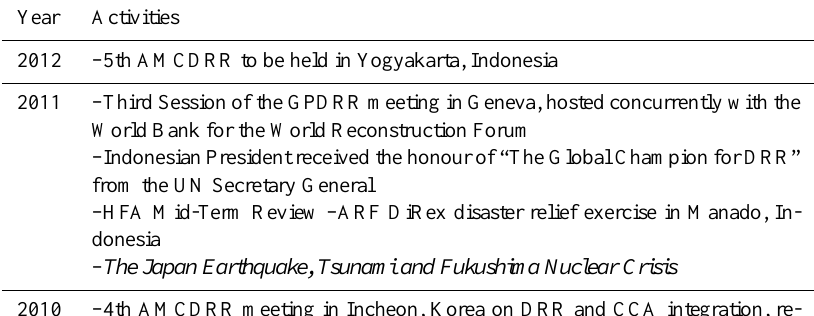
Table 3. Important timelines for multi-stakeholder platforms from global to local